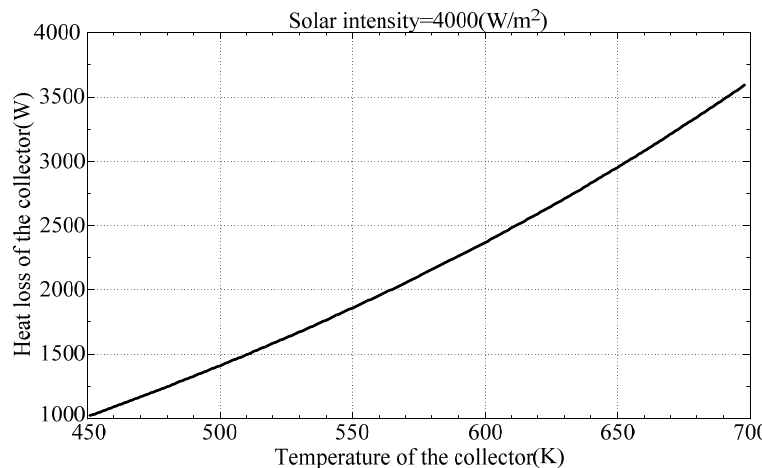
Figure 2. Heat loss from collector to the